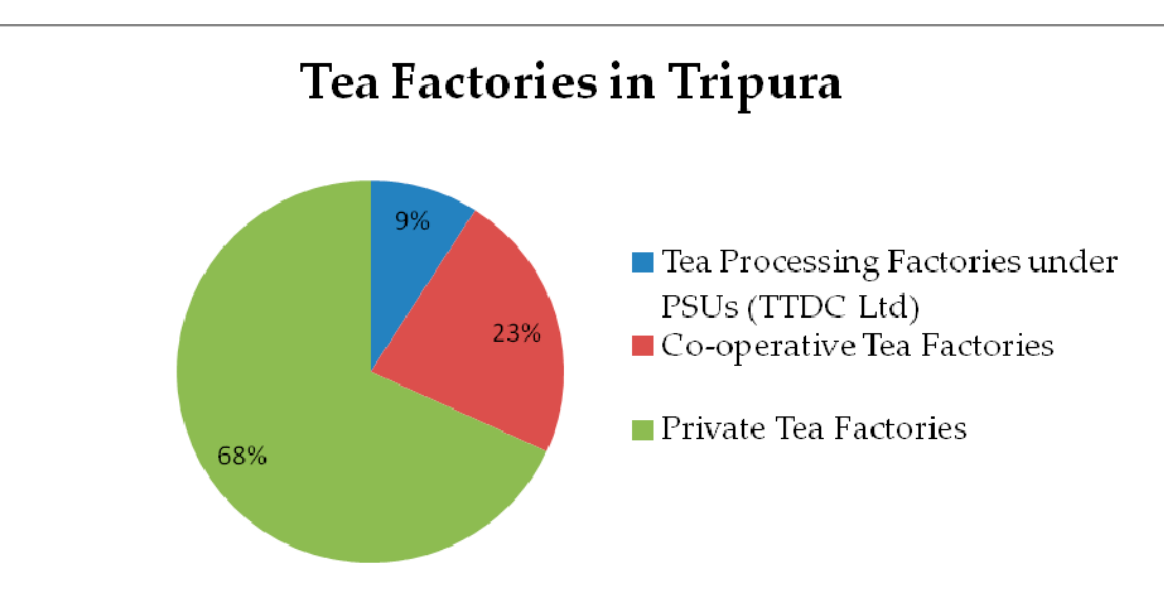
Figure 2. Pie chart showing the position of Tea Estates in Tripura.